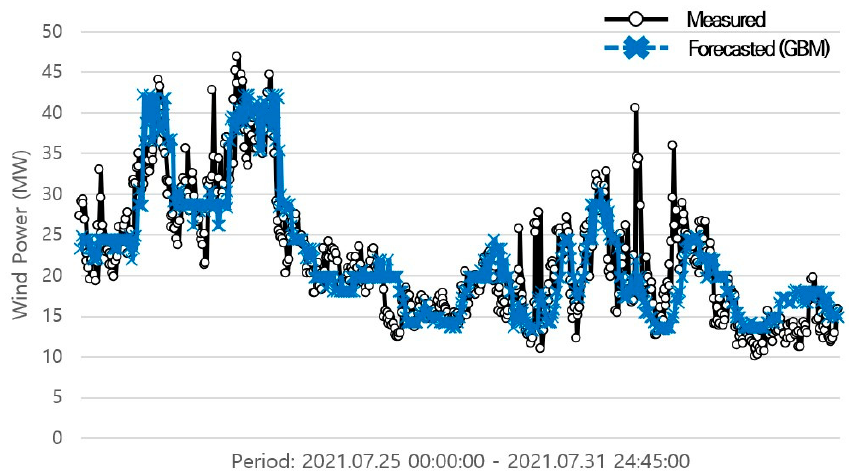
Figure 2. Forecasting results of the GBM model trained by month (July).